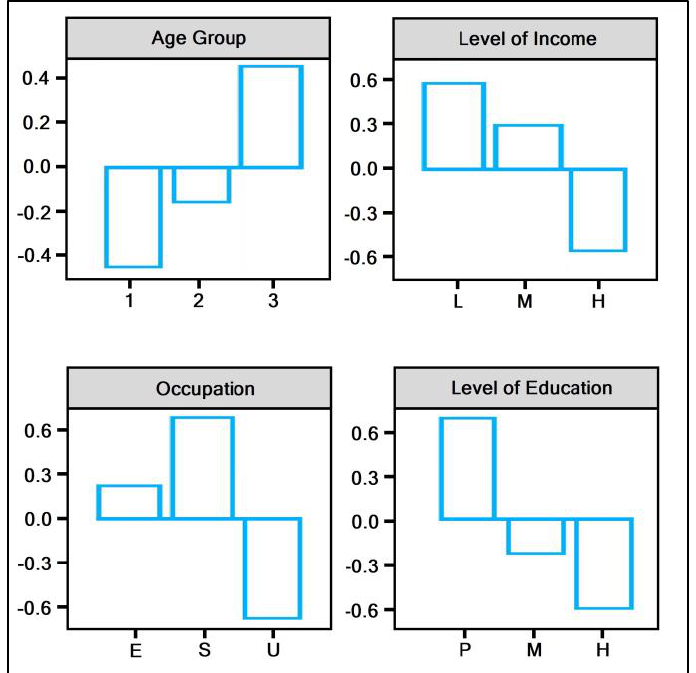
Figure 2. Patient loss ratio for cervical cancer investigations during the COVID-19 pandemic. Age